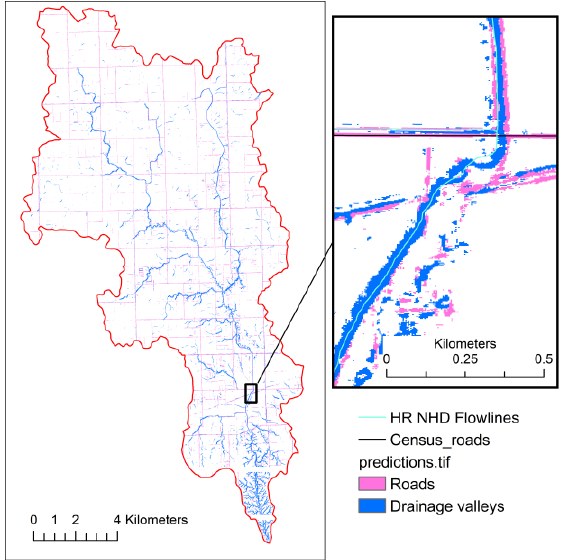
Figure 3. Road and stream valley pixels for Panther Creek watershed in central Iowa predicted from Topographic Position Index using a convolutional neural network. In the large-scale panel at the right, Census road lines and high-resolution National Hydrography Dataset flowlines are overlain in red and bright cyan,